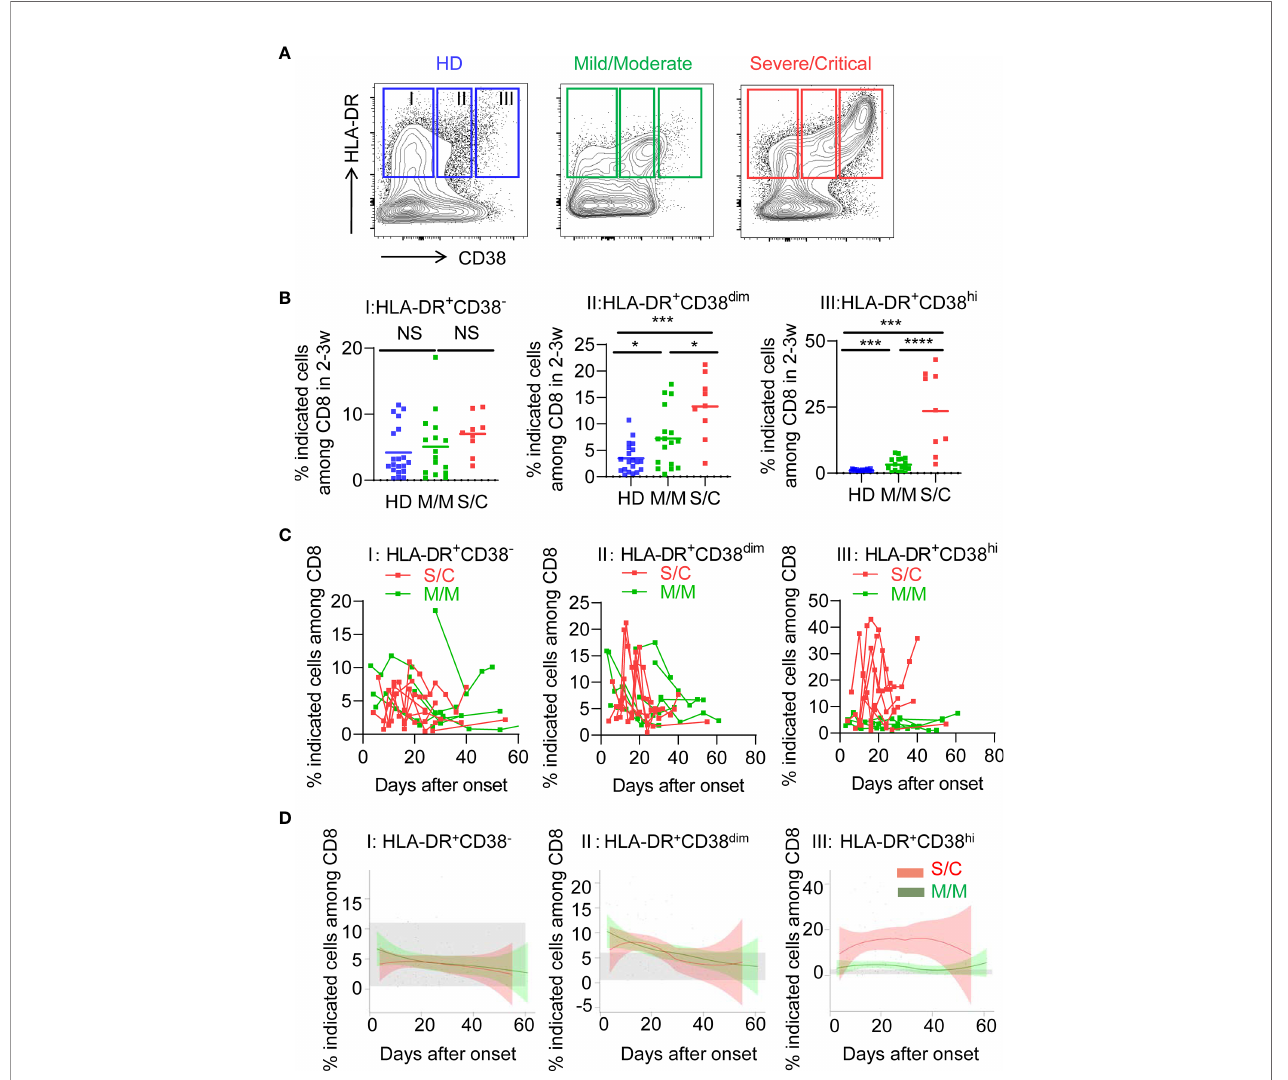
FIGURE 1 | Elevated HLA-DR + CD38 hi CD8 + T cells during acute infection of COVID-19. Flow cytometry analysis of HLA-DR and CD38 expression was performed on PBMCs collected from healthy donors, M/M and S/C patients with COVID-19 infection. (A) Representative FACS contour plots showed three subpopulations of HLA-DR + CD8 + T cells from healthy donor and COVID-19 patients: HLA-DR + CD38 − (I), HLA-DR + CD38 dim (II), HLA-DR + CD38 hi (III). (B) Scatter dot plots of the three percentages of HLA-DR + CD8 + T cells from healthy donors and COVID-19 patients within 2 – 3 weeks post onset (n = 9 – 20 each group). P Values were obtained by unpaired two-tailed Student ’ s t tests and Mann – Whitney U test and repeated measures by one-way ANOVA or Kruskal-Wallis test followed by Tukey ’ s or Dunn ’ s multiple comparisons test. *P < .05, **P < .01, ***P < .001, ****P < .0001. (C) Longitudinal data of three subpopulations were graphed for eight S/C and seven M/M patients with three time points at least. (D) Temporal changes of three subpopulations in M/M (n =32) and S/C (n = 10) groups during hospitalization were shown. The 95% con fi dence interval indicated by colored areas. The normal range of each population was gray shaded